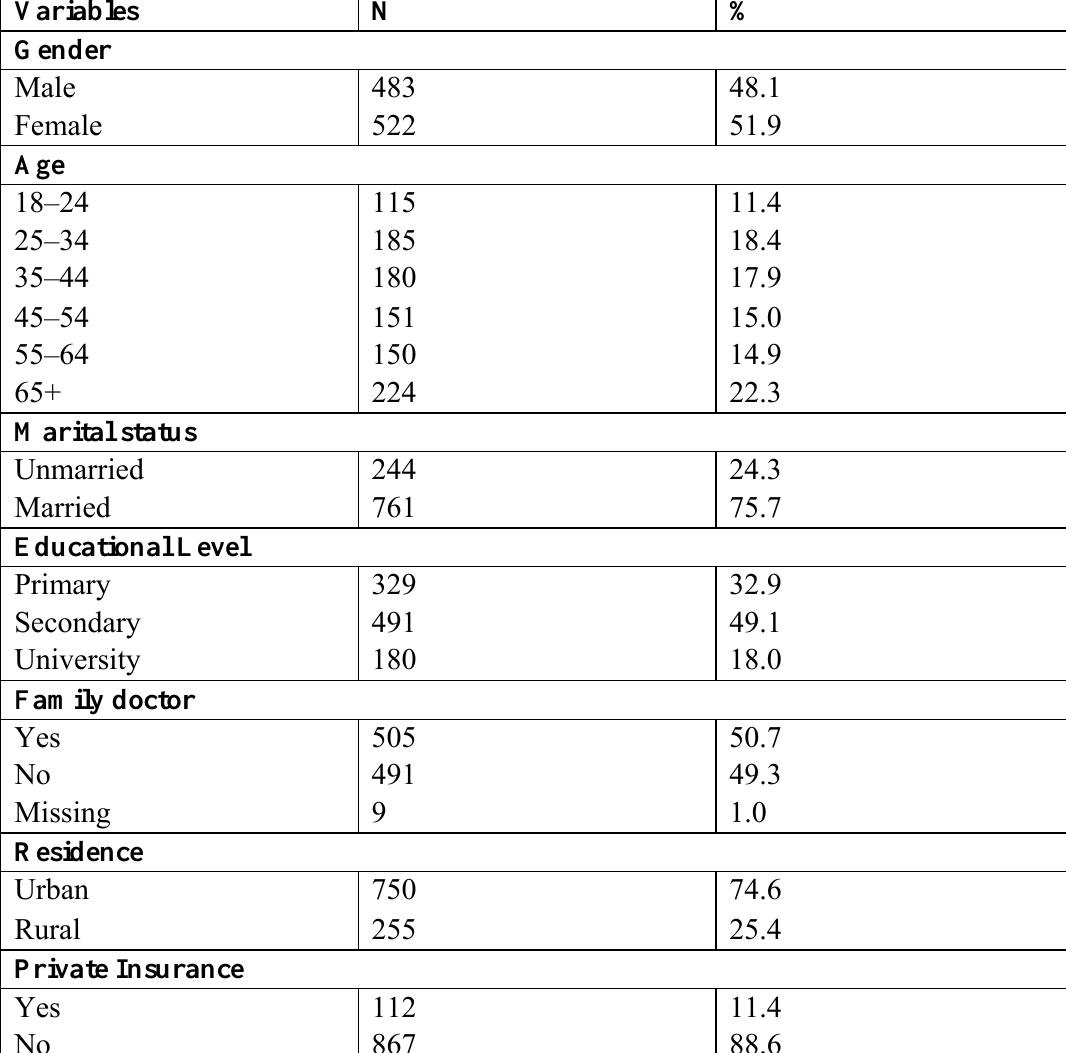
Table 2. Socio-demographic characteristics and use rates of the